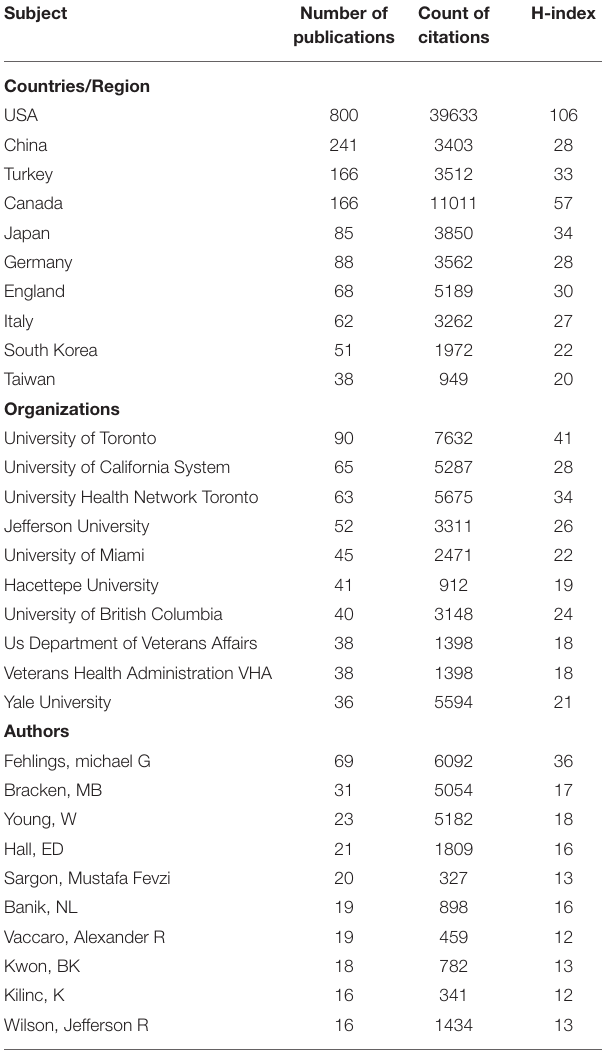
TABLE 2 | The top ten countries, organizations, and authors of spinal cord injury and glucocorticoid